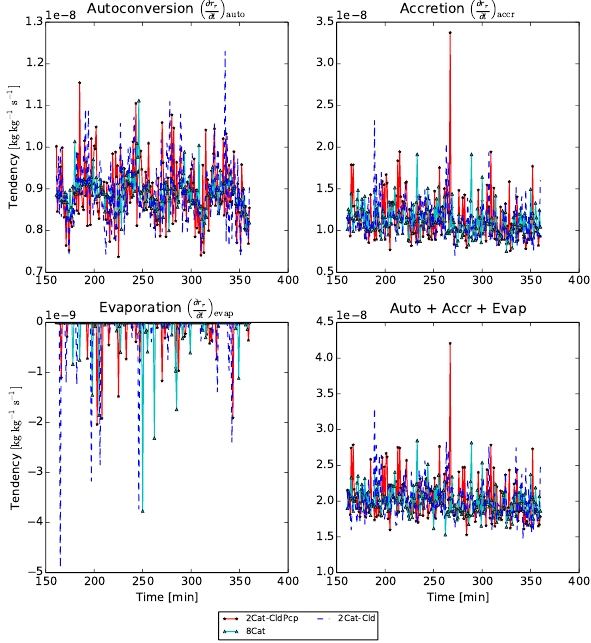
Figure 5. DYCOMS-II RF02: the root-mean-square error (RMSE) of SILHS simulations as a function of sample points for the DYCOMS-II RF02 stratocumulus case. The error is calculated at the importance sampling level and is averaged over all timesteps of the simulation. The LH-only, 2Cat-Cld, and 2Cat-CldPcp meth- ods are expected to have roughly the same behavior in a case like DYCOMS-II RF02 that has cloud fraction near 100%. The 8Cat method still improves the estimates of autoconversion and accre- tion because it is able to flexibly allocate points within the cloudy region of the sample space.